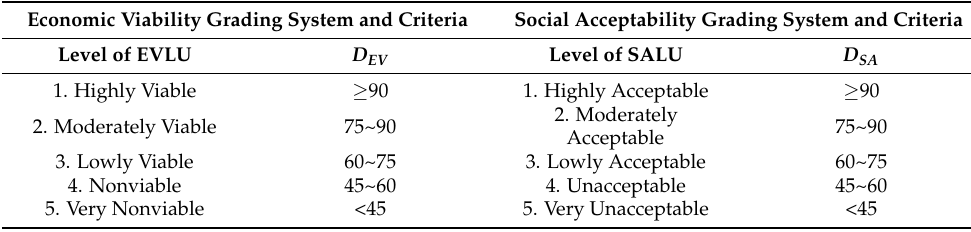
Table 5. Grading system and standard for EVLU and